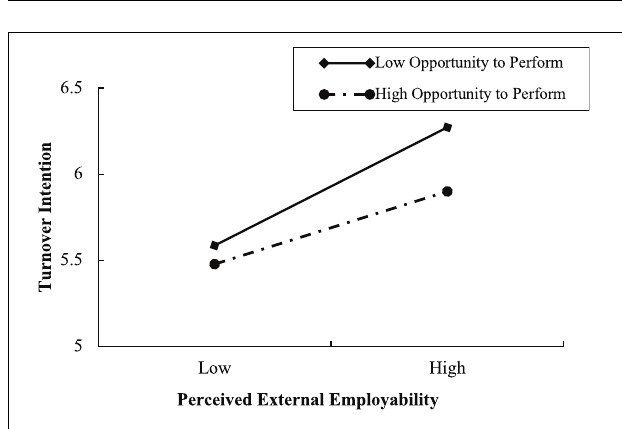
FIGURE 2 | The moderating effect of opportunity to perform on the relationship between perceived internal employability and turnover intention.